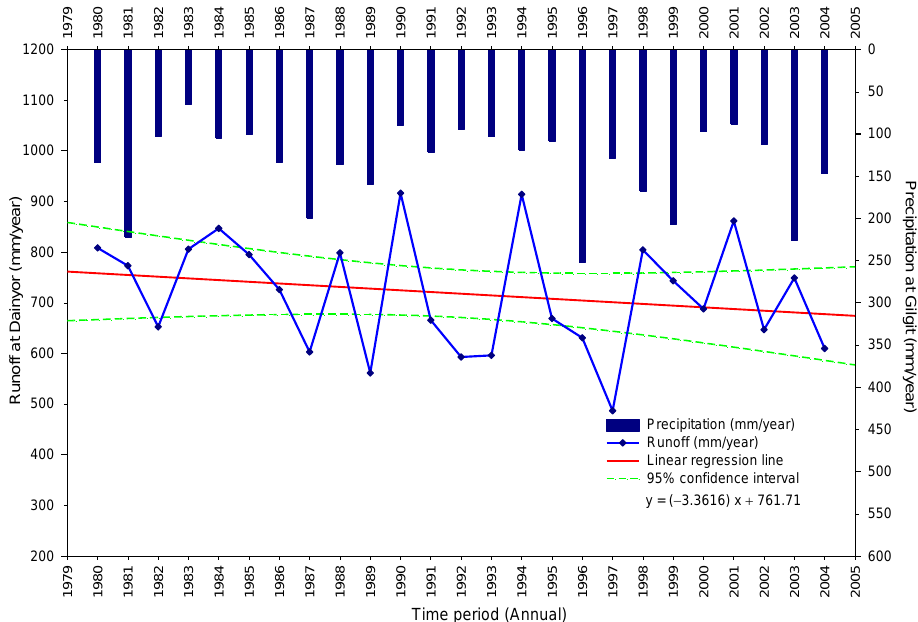
Fig. 9 Annual flow trend in Hunza River at Dainyor Bridge and total annual precipitation at Gilgit over 25 years (1980–2004).